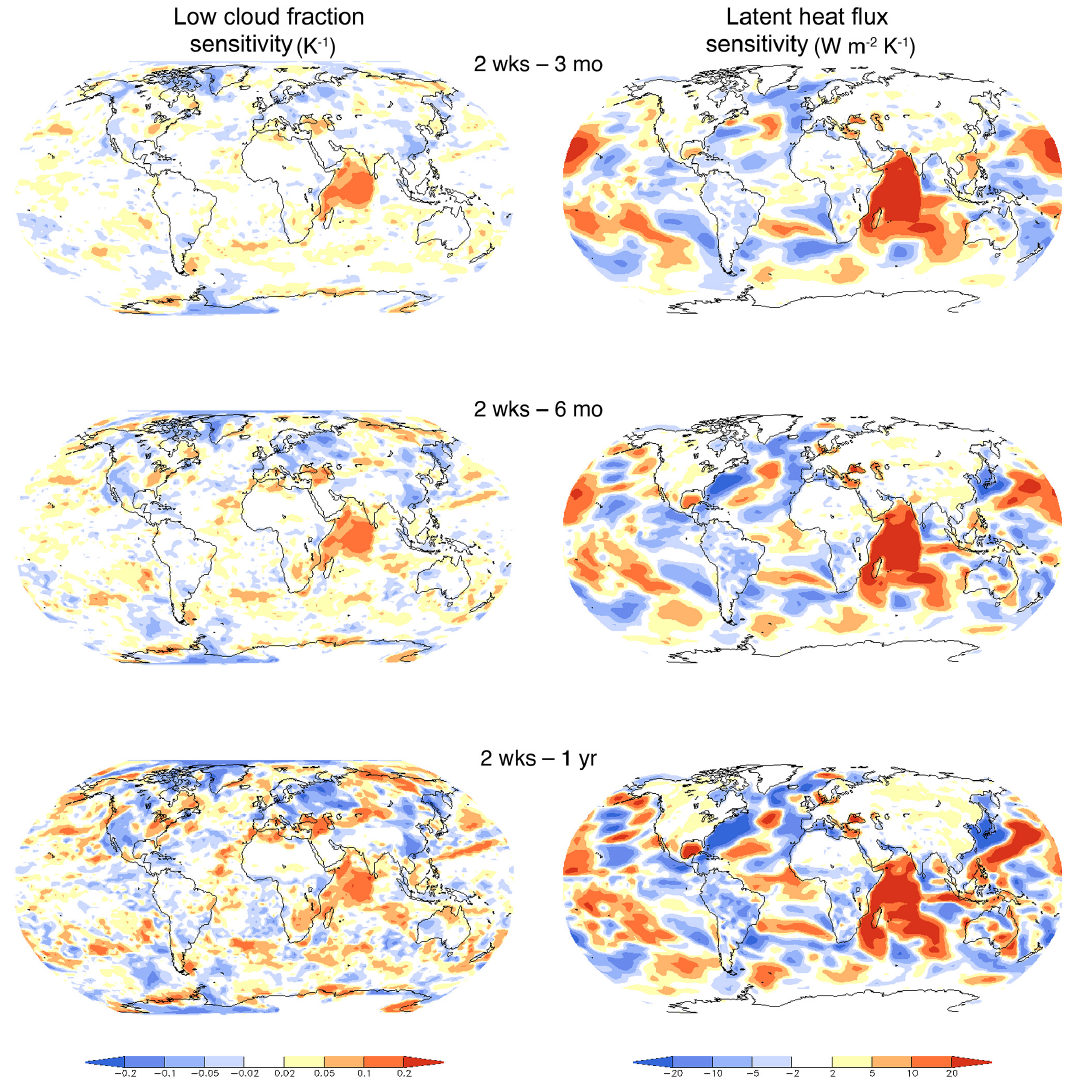
Figure 8. As in Fig. 6 and 7 but for bands including wider ranges of